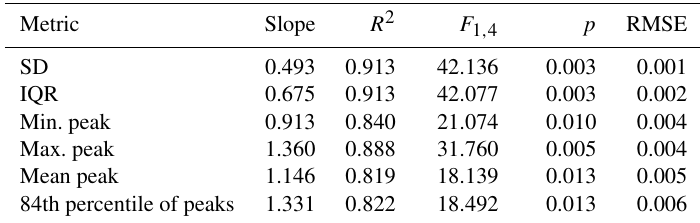
Table 4. Performance statistics of applied linear models.